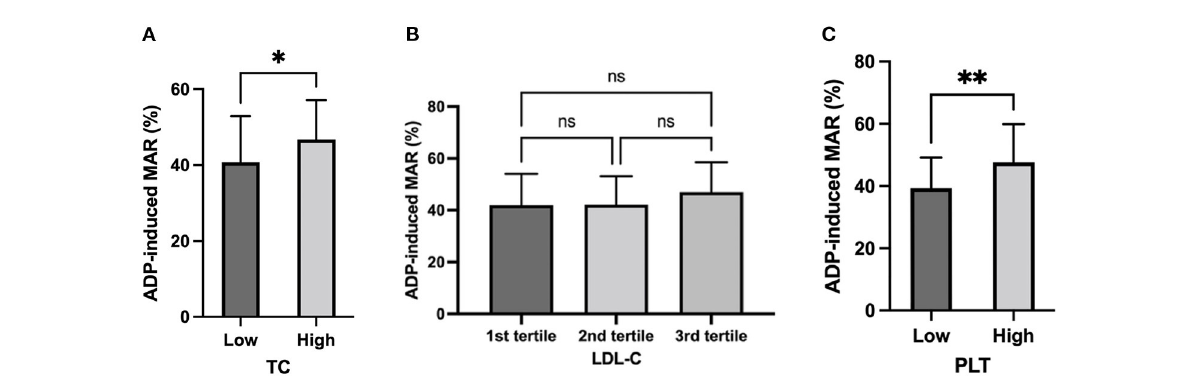
FIGURE3 ADP-induced platelet aggregation stratified by TC, LDL-C, and PLT. ADP-induced platelet maximal aggregation rate (MAR) in healthy subjects stratified by TC (A) , LDL-C (B) , and PLT (C) . *: P < 0.033, **: P < 0.002, ns: P > 0.1234.